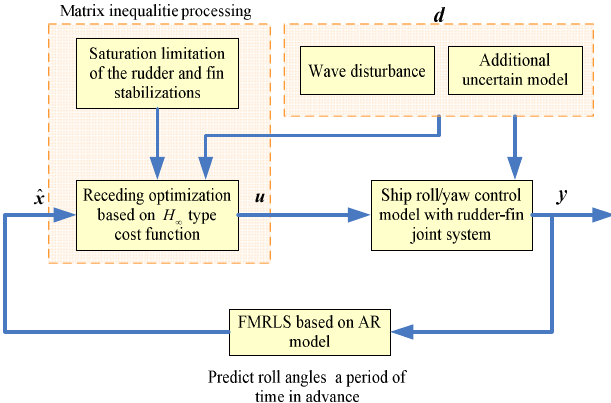
Figure 1. Schematic diagram of the H ∞ -type state feedback model predictive control ( H ∞ -SFMPC) system.